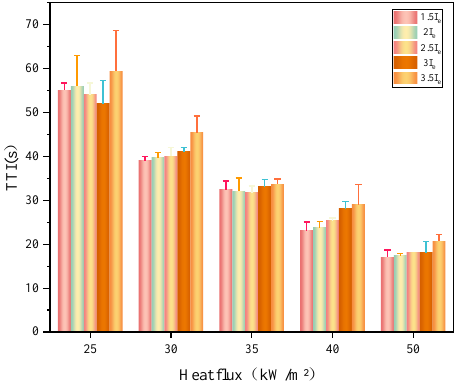
Figure 4. TTI values for overloaded wires.